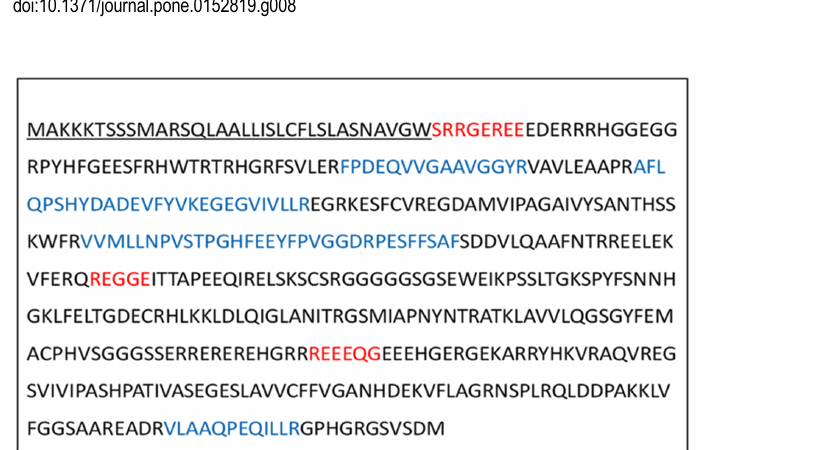
Fig 8. Far UV CD spectra of cupincin. 0.1 mg/ml of protein in 50 mM Tris-HCl, pH 7.5. Accumulations of three runs are shown.